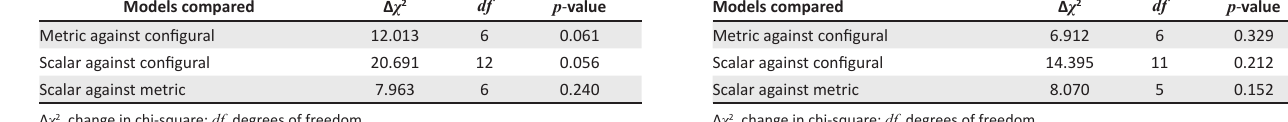
TABLE 4: Results of the invariance testing based on branch membership. Models compared